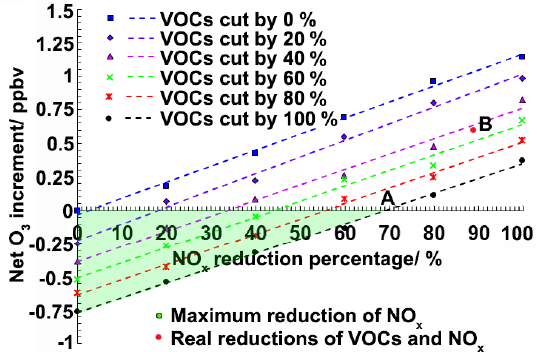
Figure 13. Net O 3 increment as a function of the reduction per- centages of VOCs and NO x in LPG-fueled vehicle exhaust. The highlighted area indicates zero O 3